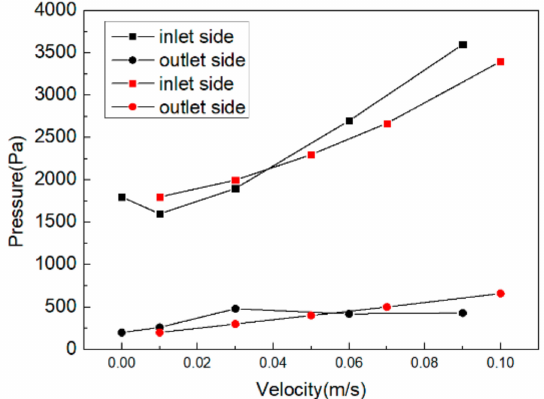
Figure 9. Pressure around microdroplet influenced by velocity: black symbol means the pressure change with the relative velocity of microdroplet; red symbol means the pressure change with microdroplet velocity when there is no relative velocity between microdroplet and culture